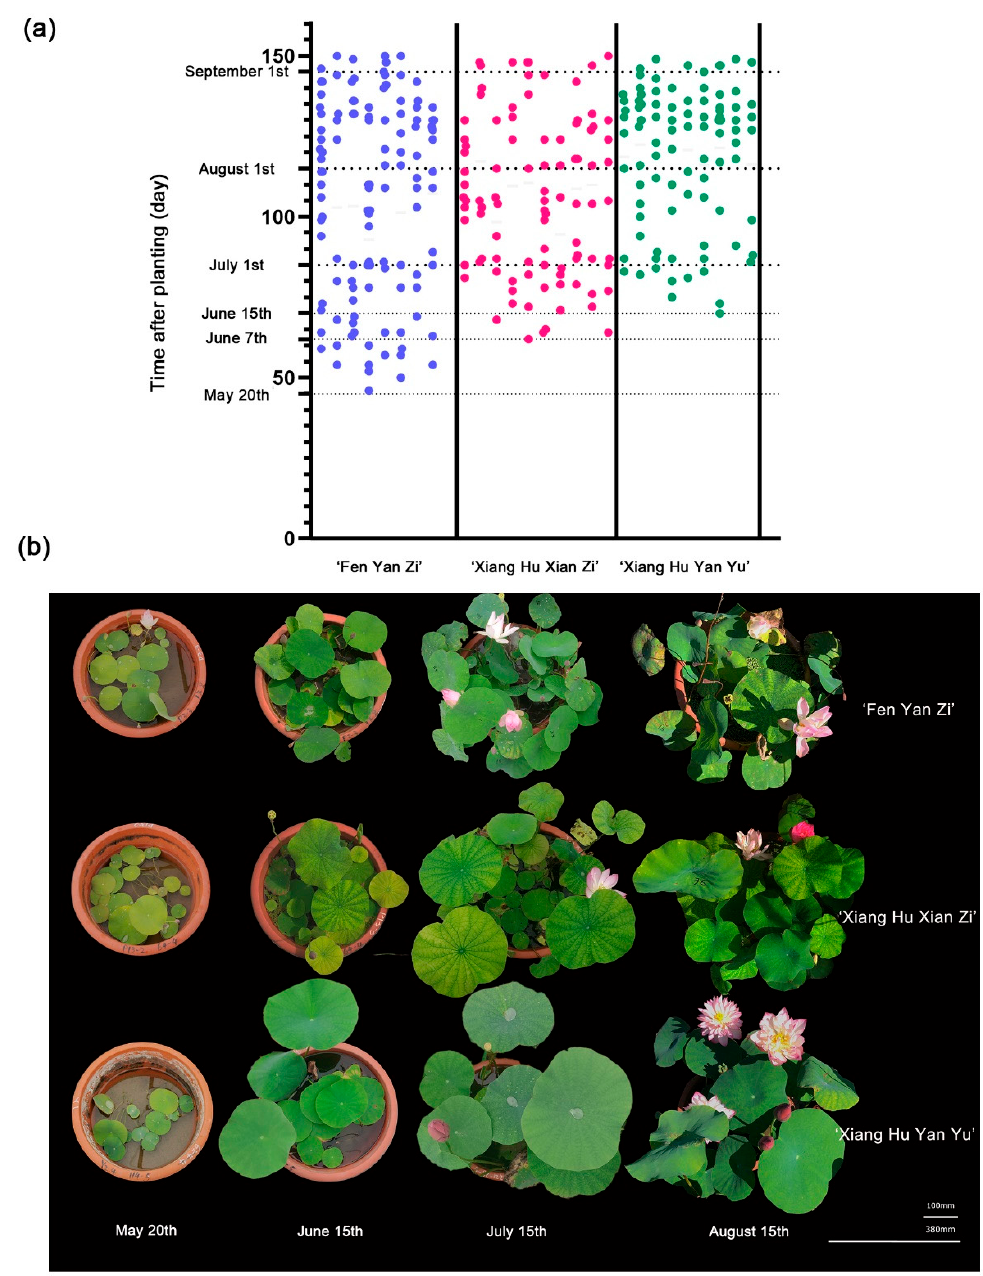
Figure 4. Flowering time of three typical cultivars in 2020. ( a ) Scatter plots of blooming time of three cultivars. ( b ) The growth and development of three cultivars in four periods.